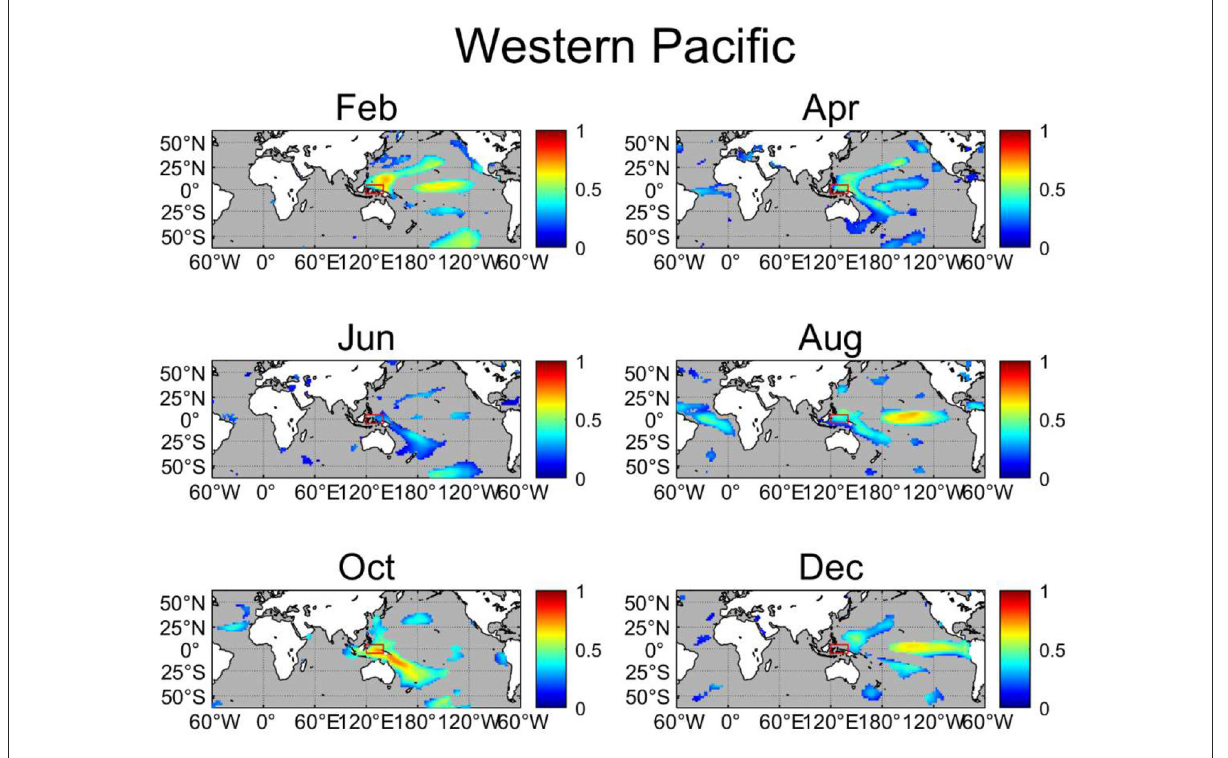
FIGURE9 As in Figure 8, but for the western equatorial Pacific (120–140 ◦ E, 5 ◦ N